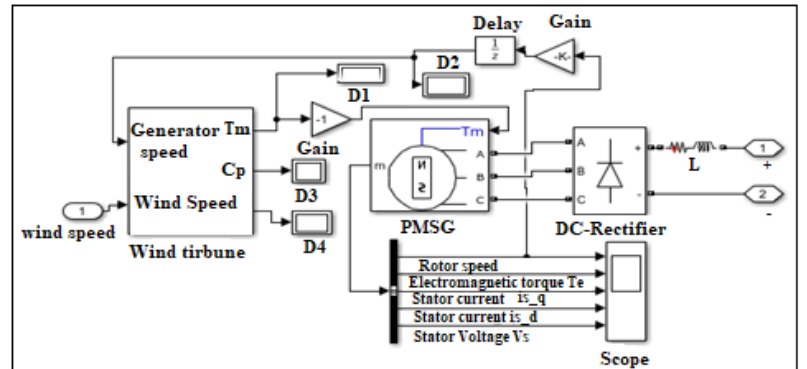
Figure 15. Simulink model of the wind turbine. Figure 16 diagrams the real database of the wind speed, while the power and voltage of the wind turbine are reported in Figure 17.